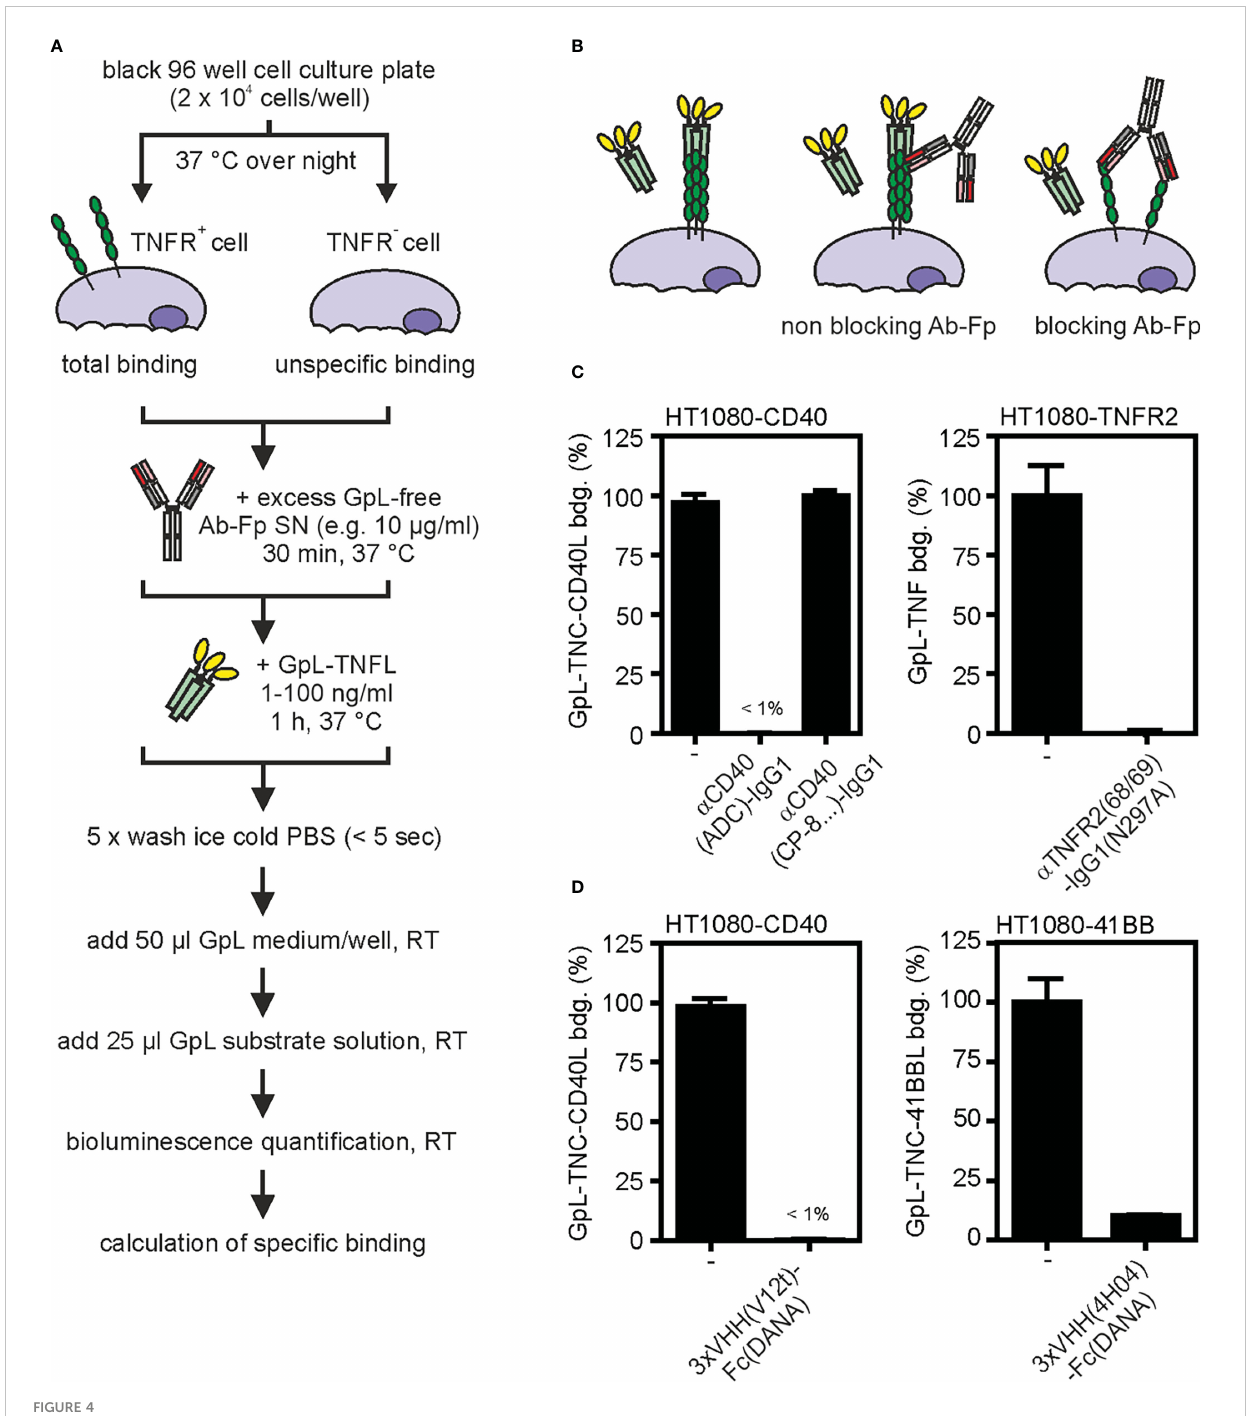
FIGURE 4 Effect of anti-TNFR antibodies on TNF ligand binding. (A) Process chart of the method. (B) Scheme of ligand binding of blocking or non-blocking TNFR antibody fusion proteins (Ab-Fp). (C, D) The indicated HT1080-transfectants and corresponding TNFR negative HT1080 cells were seeded in black clear bottomed 96 well cell culture plates overnight (2 x 10 4 ). Next day, cells were incubated with an excess of the indicated “ GpL-free ” anti- TNFR antibody (10 µg/ml) (C) or “ GpL-free ” single domain antibody (VHH) Fc fusion proteins (D) for 30 minutes. Then a TNFR-speci fi c GpL-TNFL was added in a concentration close to its K D value (typically 1 – 100 ng/ml) and remaining speci fi c binding was